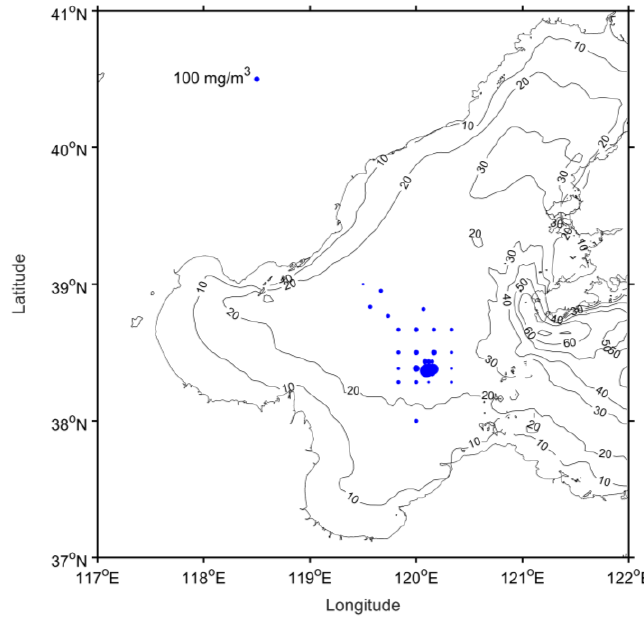
Figure 2. Location of the TPH sampling stations (unit: mg/m 3 ).